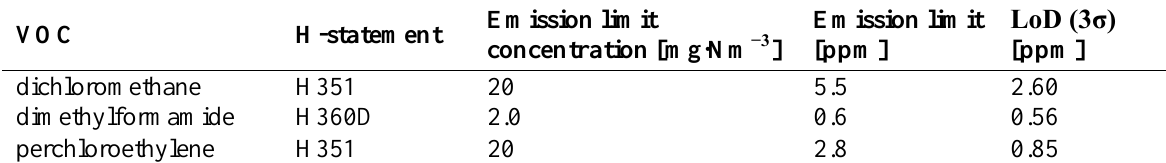
Table 5. Emission limits according Directive 2010/75/EU and the experimentally achieved LoD with a measurement time of 8.5